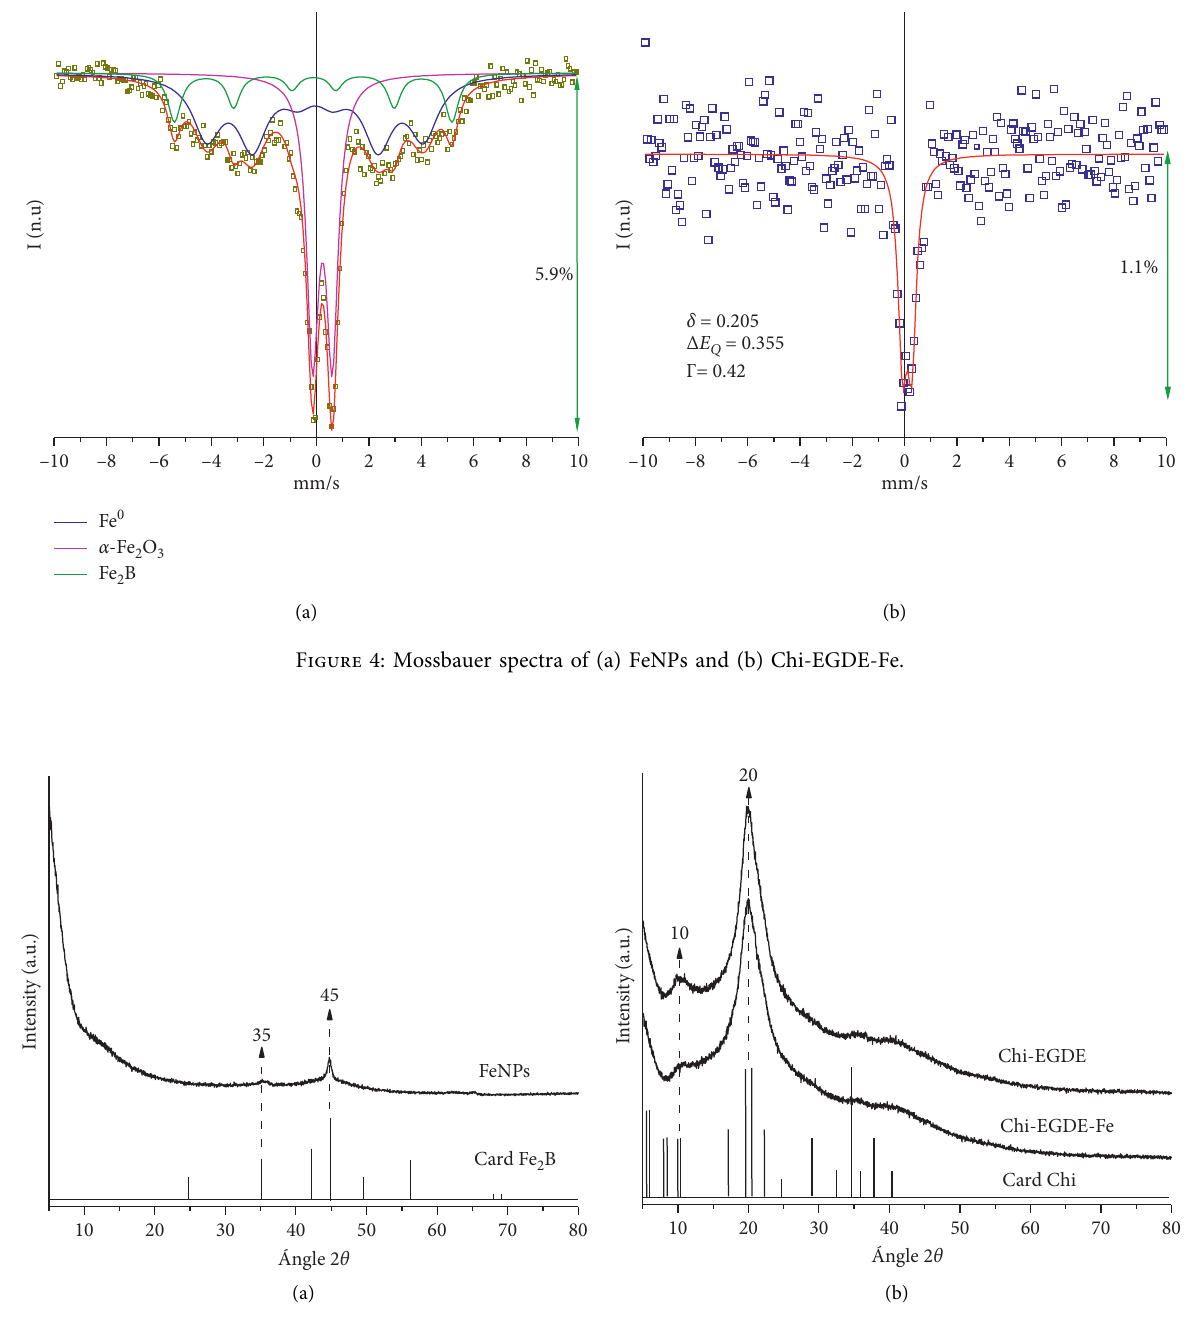
Figure 5: XRD patterns of (a) FeNPs and (b) Chi-EGDE and